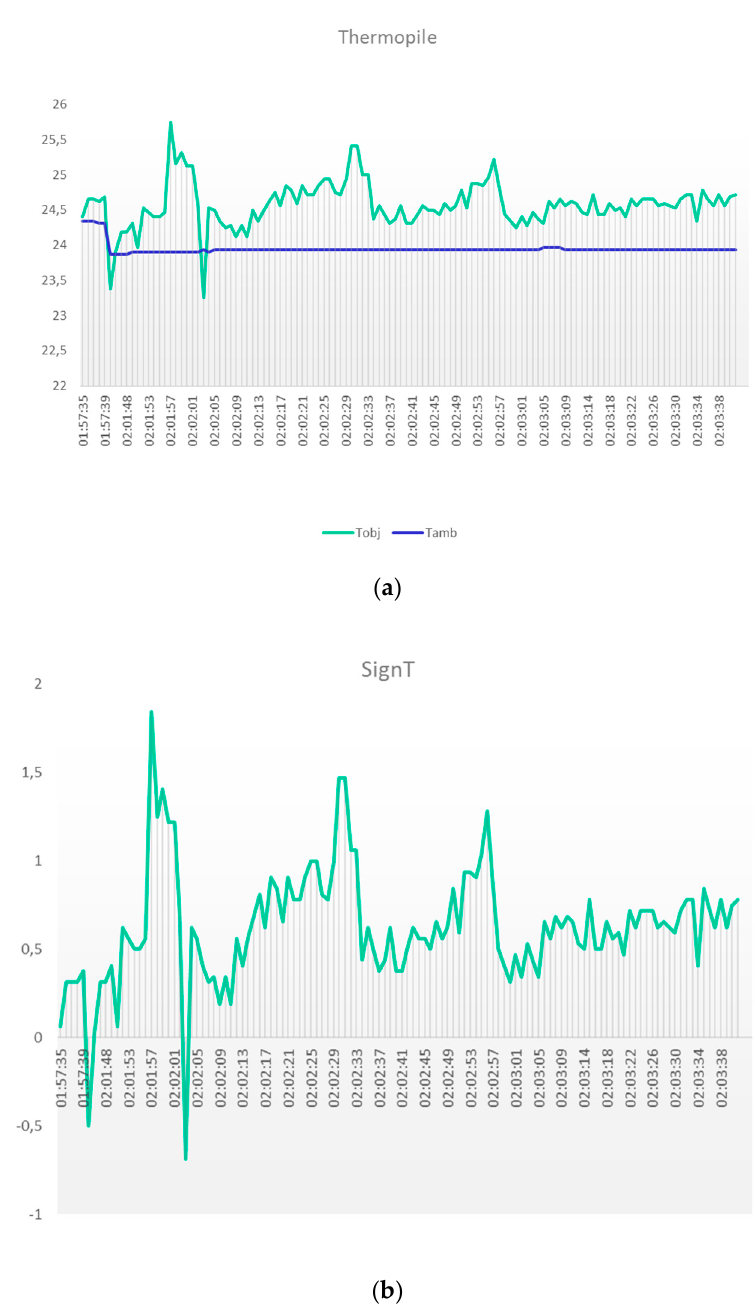
Figure 3. Response of the thermopile sensor after modification of the measurement conditions, as shown in figure 3( a ) and 3( b ).